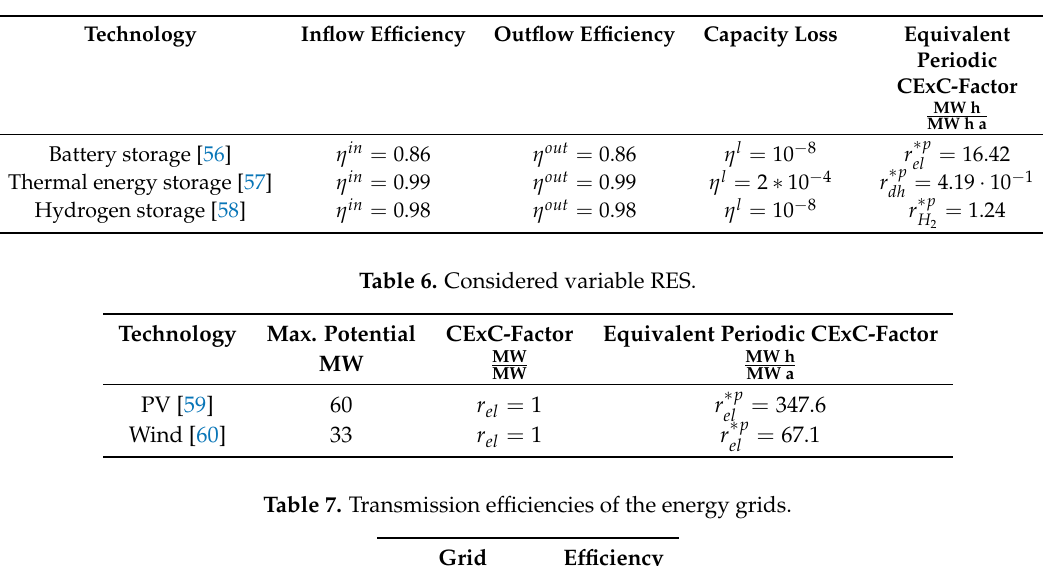
Table 5. Considered energy storage technologies.